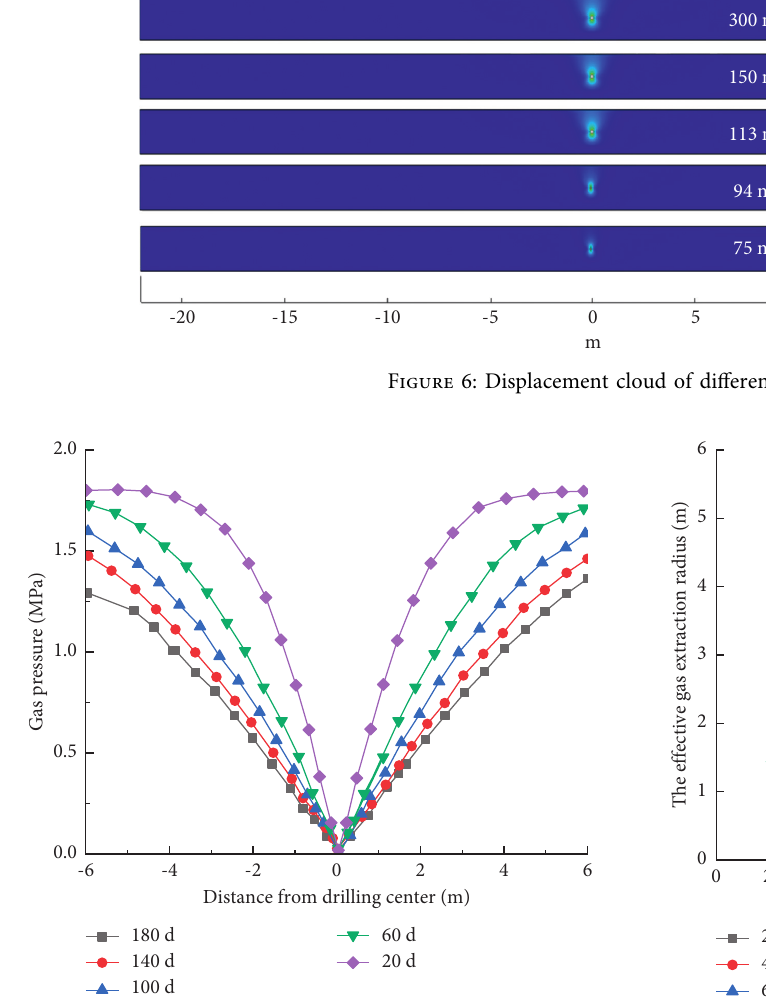
Figure 8: Variation of effective drainage radius with time under different initial permeability.